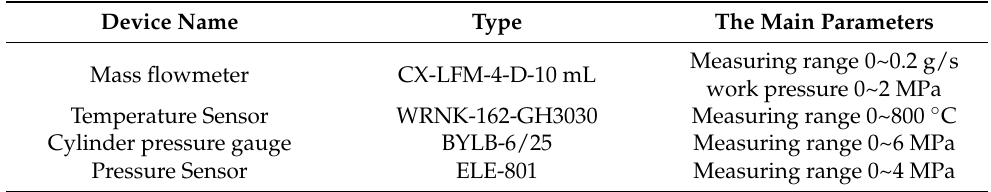
Figure 1. Schematic ( a ) and Image ( b ) of the ADN-based propellant capillary flow experimental system. Table 1. Instrument specifications.